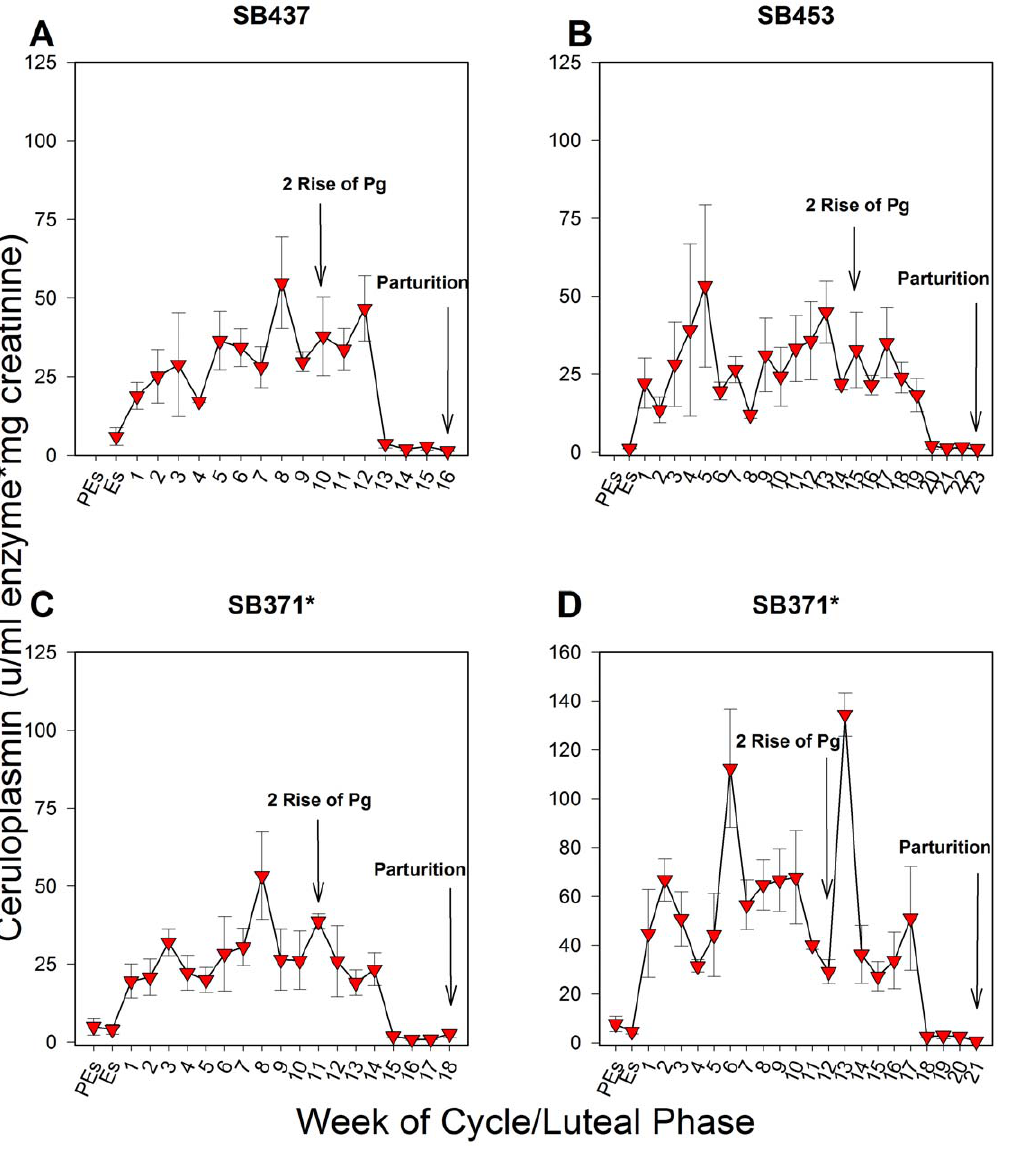
Figure 2. The levels of active ceruloplasmin in urine for female giant pandas during representative term pregnant cycles. Panel A: Term pregnancy in 2005 for SB437 (SNZP). Panel B: Term pregnancy in 2006 for SB452 (ZA). Panel C: Term pregnancy in 1999 for SB371 (SDZ). Panel D: Term pregnancy in 2003 for SB371 (SDZ). Animals were artificially inseminated (SB437; SB452) or artificially inseminated (SB371, reproductive cycle 1999) and bred naturally (SB371, reproductive cycle 2003). The amount of time active ceruloplasmin levels remained elevated in urine was dependent upon the gestation length of each term pregnancy, but levels consistently remained high through approximately half of the secondary rise in progestagens and then decreased to at or below proestrus/estrus levels 20–24 days prior to parturition in each pregnancy examined. SB371 was confirmed pregnant with twins by ultrasound in 2003, but only gave birth to one cub. All other term pregnant cycles characterized produced a singleton cub. Pg=Progestagen; PEs=Proestrus; Es=Estrus; Numerical numbers=weeks of the luteal phase. Variations in the x and y axes exist to accommodate variable concentrations and durations. Data are weekly means 6 SEM; n=5 reproductive cycles, representative cycles (n=4) are presented herein. *Samples from SB371 were analyzed blind, without prior knowledge of cycle outcome.